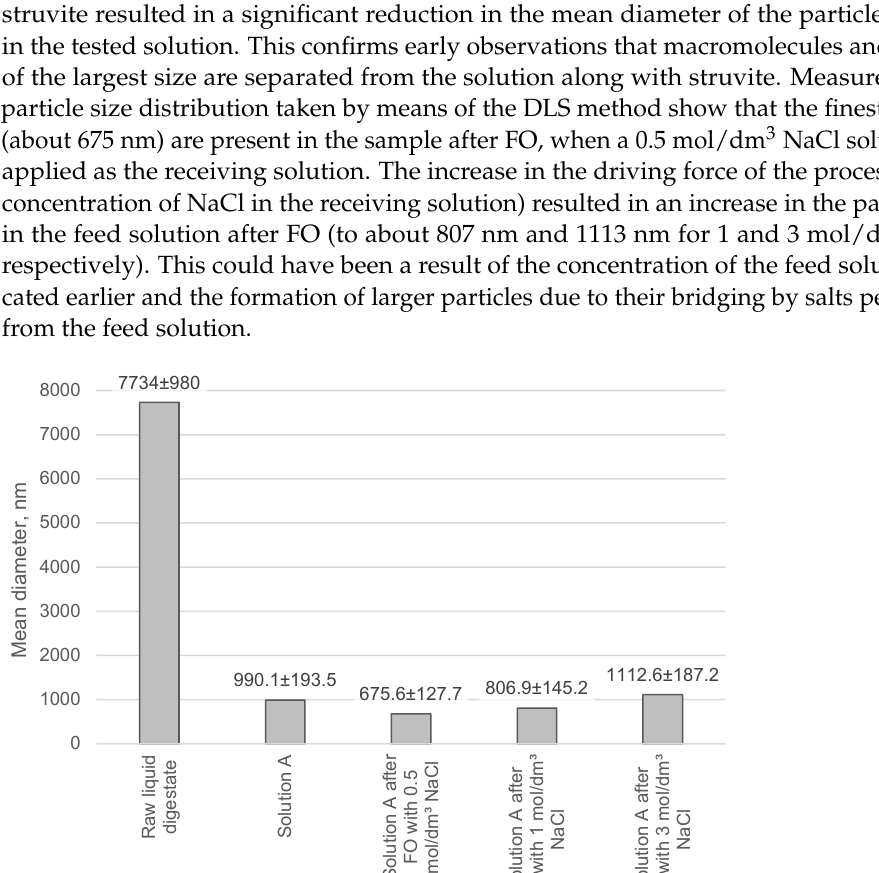
11 of 17 Figure 8. Visual changes in the quality of the liquid fraction of the digestate after successive stages of purification (a—liquid raw digestate; b—solution A (after struvite precipitation); c—solution A